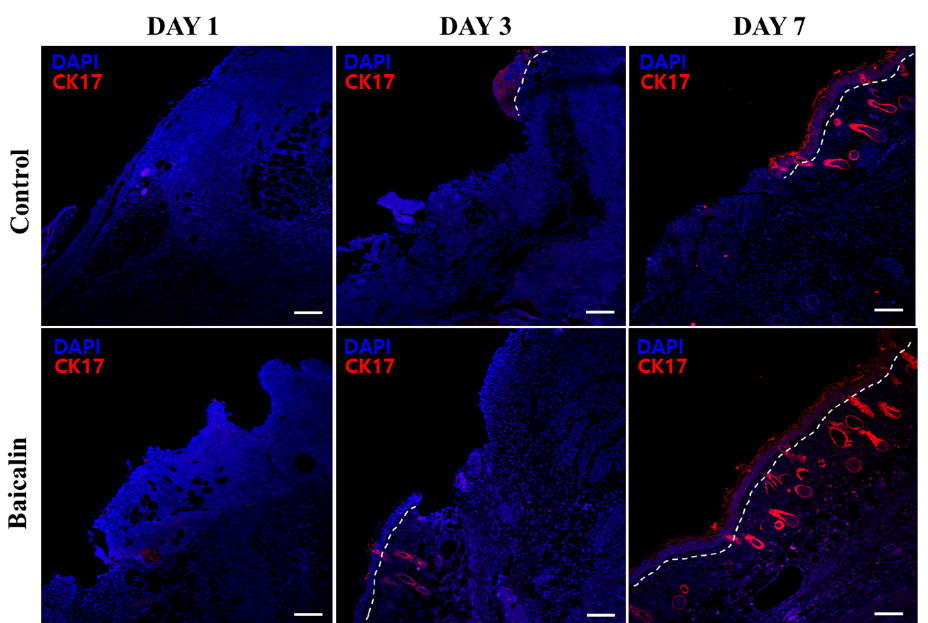
Figure 5. Baicalin promotes keratinocyte migration in pressure ulcer wound healing. Representative immunofluorescence images in histological sections of pressure ulcer skin lesions in mice. CK17 (red); DAPI (blue). The epithelial layer is distinguished from the dermis by a white dotted line. All images are representative of three independent experiments ( n = 18). Scale bar: 100 µ m. CK17, cytokeratin 17; DAPI, 4 ′ ,6-diamidino-2-phenylindole.